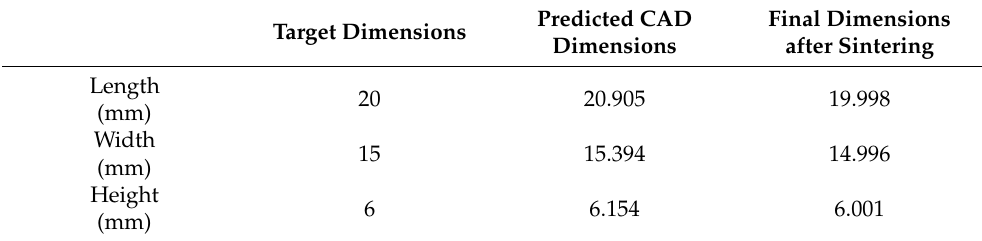
Table 9. Verification of the ML